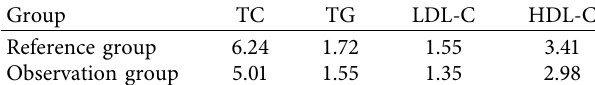
Table 1: Analysis of blood lipid levels